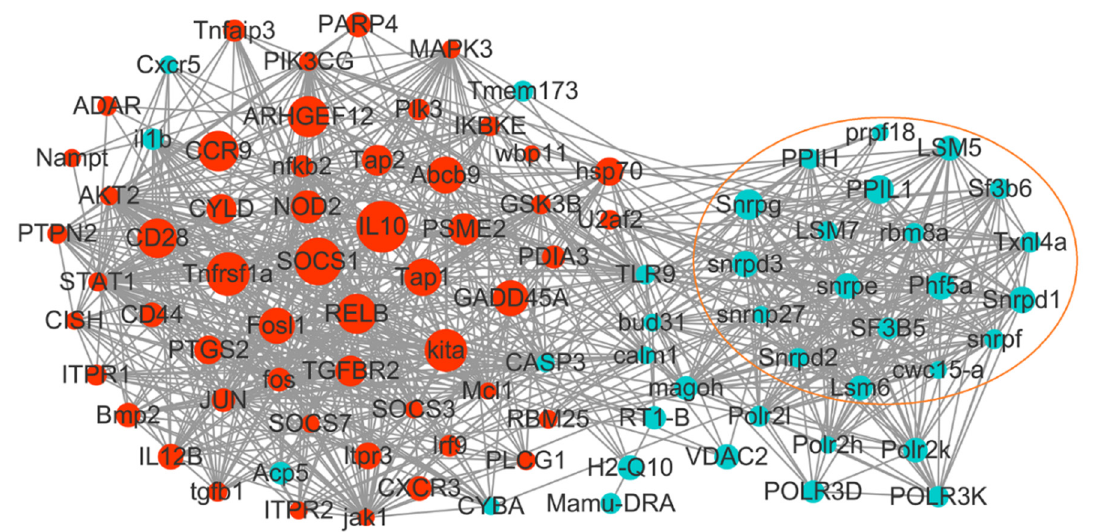
Figure 5. The interaction network formed by immune related DEGs. The nodes in the network represent DEGs, and the lines connecting different nodes denote interactions between the DEGs. Red and blue nodes represent up- and downregulated DEGs, respectively. Node size indicates the log 2 |FC| of the DEGs. The DEGs involved in spliceosome and splicing are enclosed in an orange lined circle.